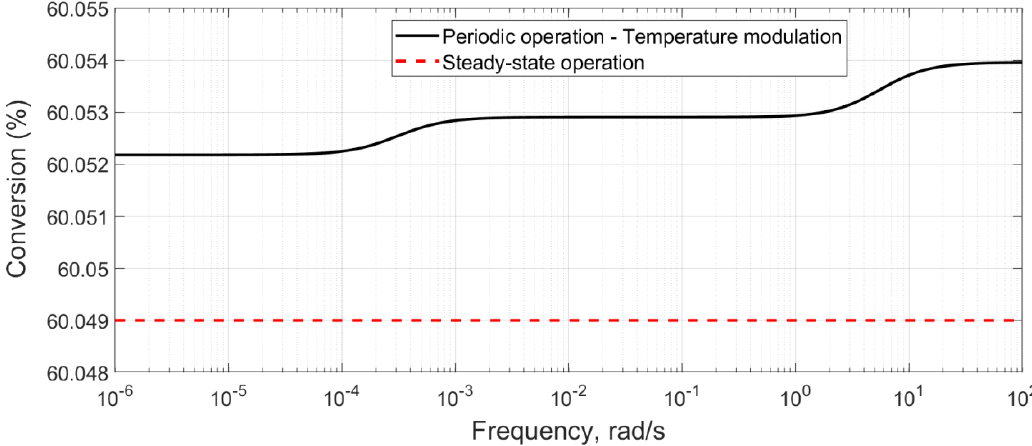
Figure 4. Comparison of the conversion for periodic operation with temperature modulation with maximal amplitude (20 K) around the steady-state point SS5 and for the corresponding steady-state operation.